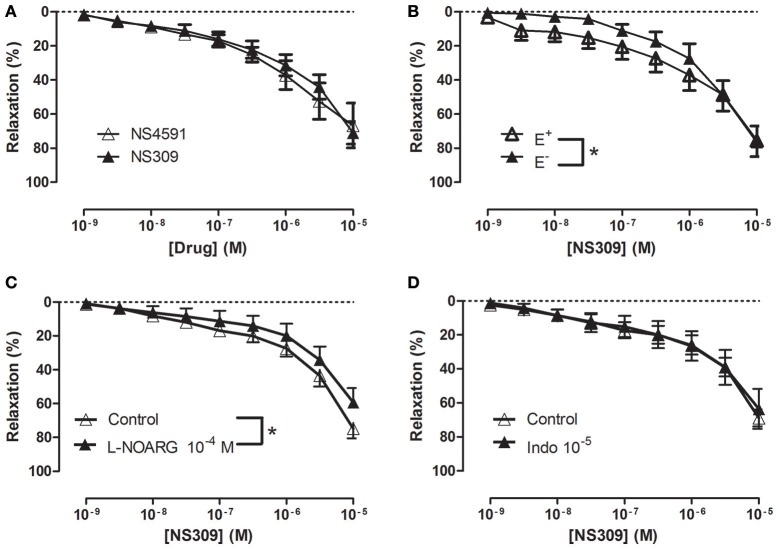
Involvement of the endothelium and nitric oxide (NO) in NS309 relaxation of rat corpus cavernosum. (A) Average concentration-response curves for NS309 (n = 10) compared with NS4591 (n = 11) in preparations with endothelium, (B) NS309 in preparations with endothelium (+E, n = 5) and without endothelium (−E, n = 5), (C) NS309 relaxation curves in the absence (n = 11) and the presence of nitro-L-arginine (L-NOARG 10−4 M, n = 7), and (D) NS309 relaxation curves in the absence (n = 6) and the presence of indomethacin (10−5 M, n = 6). Data are expressed as means ± S.E.M. *P ≤ 0.05, two-way ANOVA compared to preparations without endothelium or control preparations with endothelium.